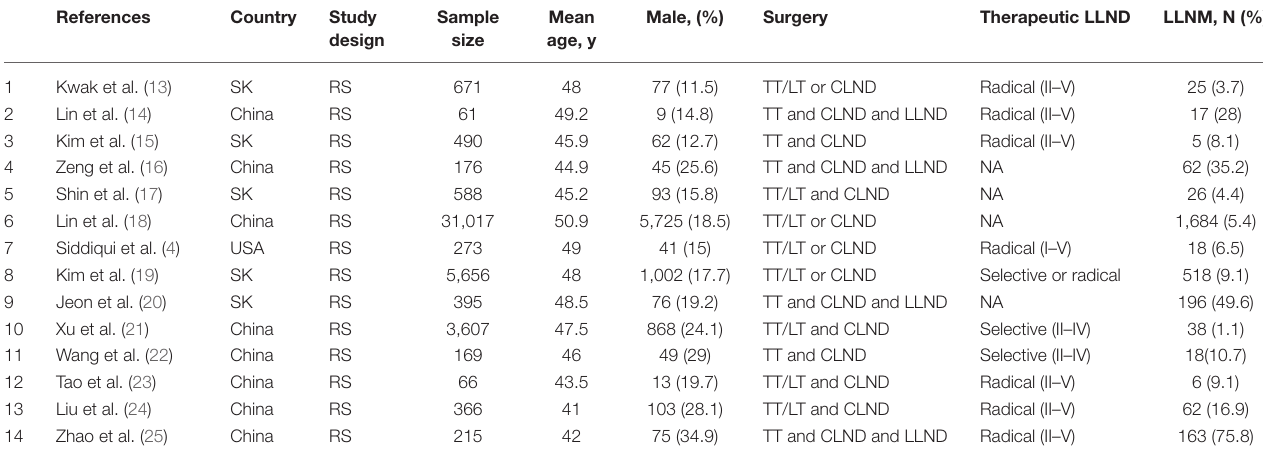
TABLE 1 | Characteristics of selected studies.